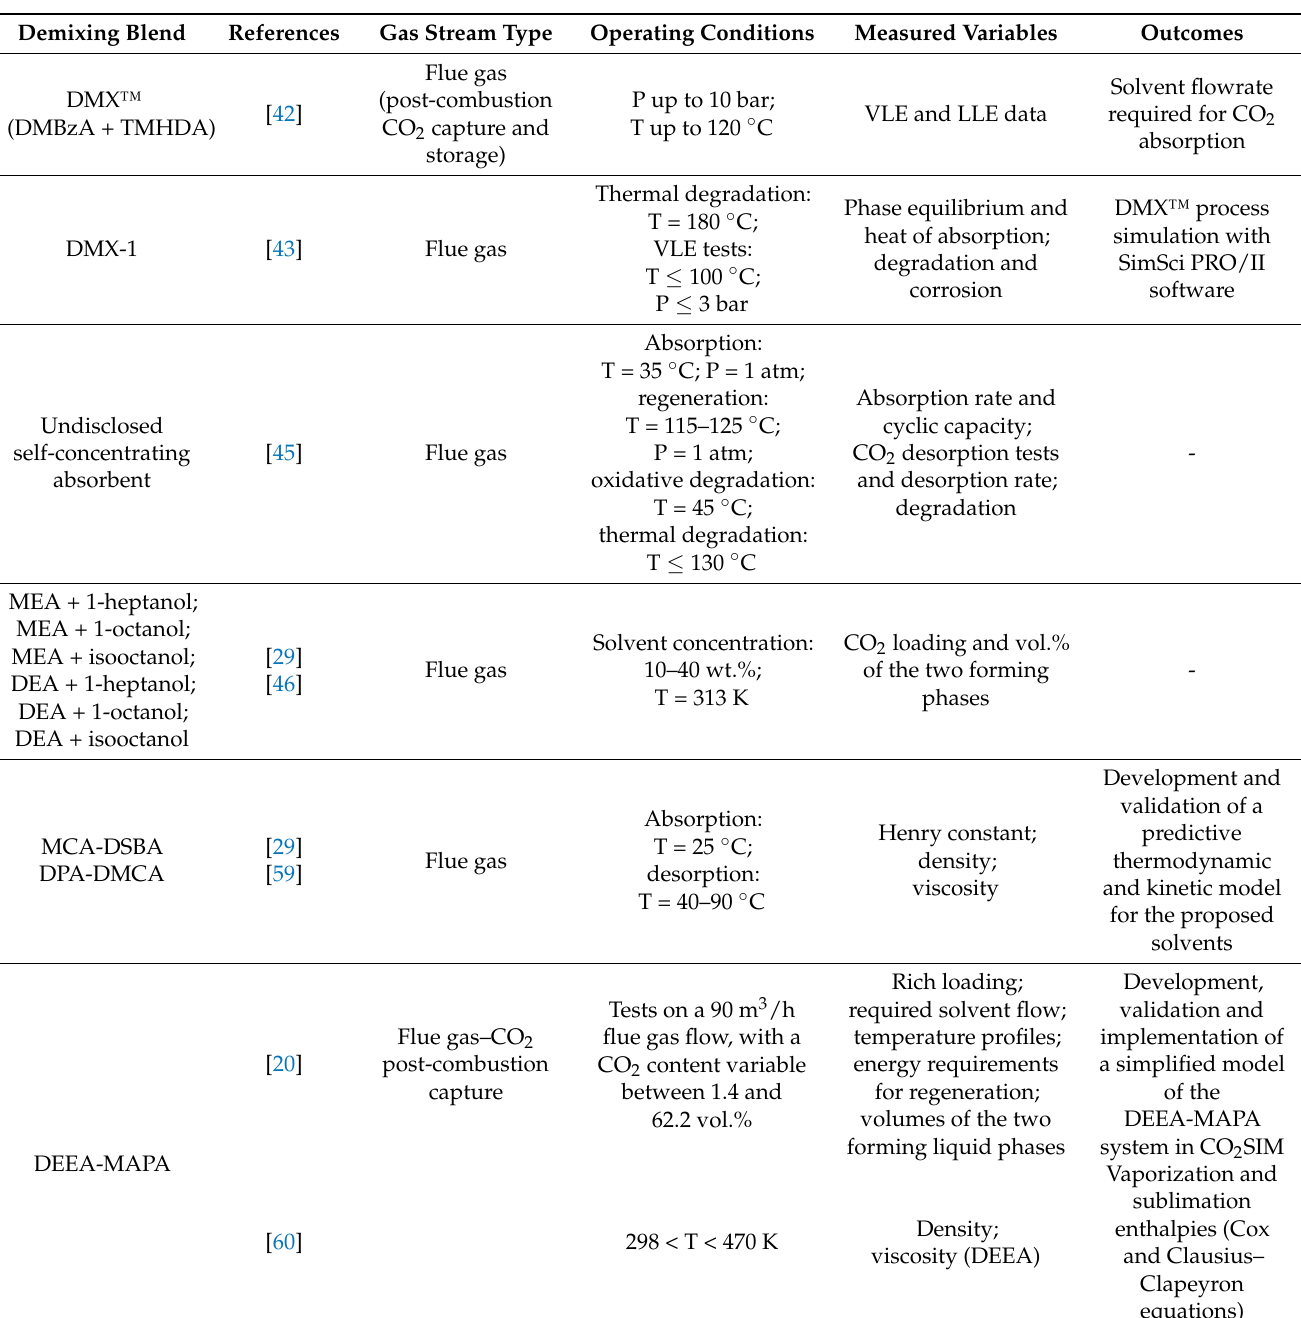
Table 2. Demixing blends studied in the literature for CO 2 capture, with relative experimental operating conditions and provided